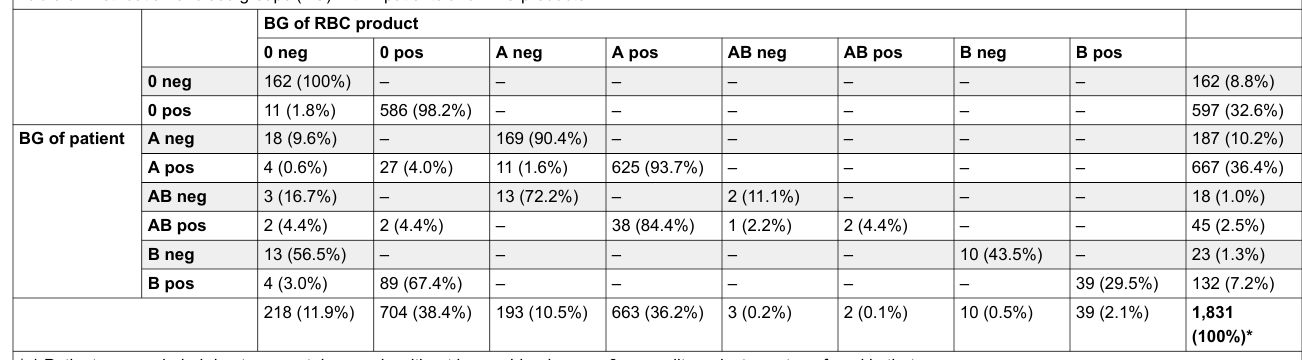
Table 3: Distribution of blood groups (BG) within patients and RBC products. BG of RBC